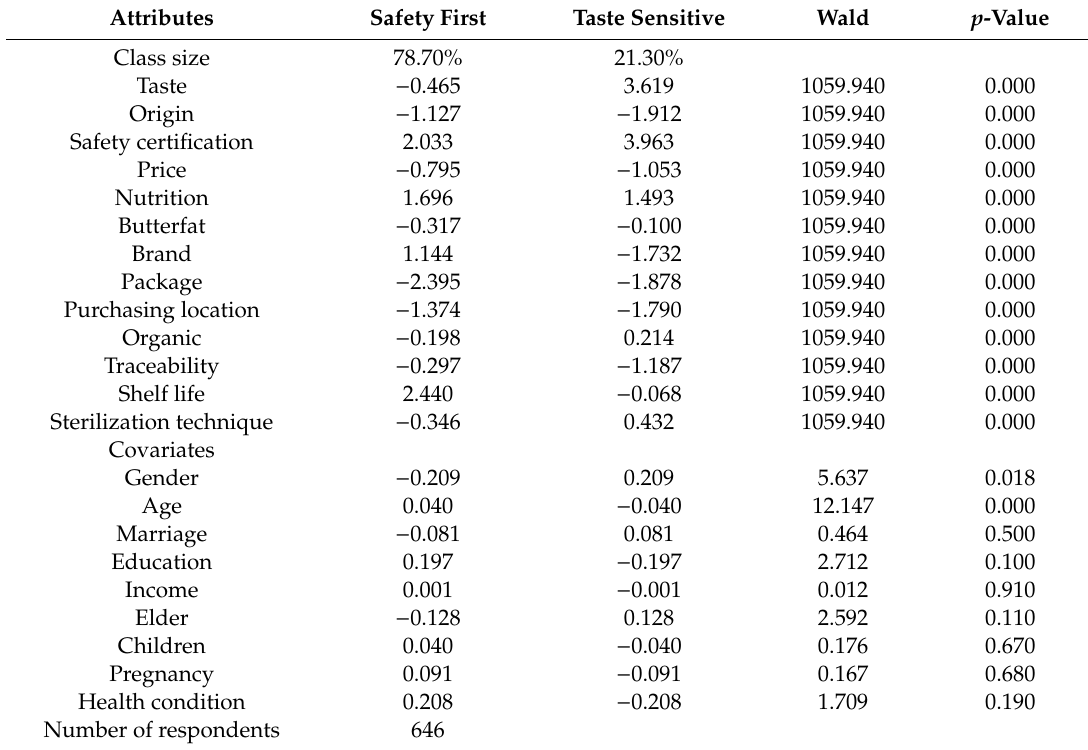
Table 6. Preference heterogeneities in developed